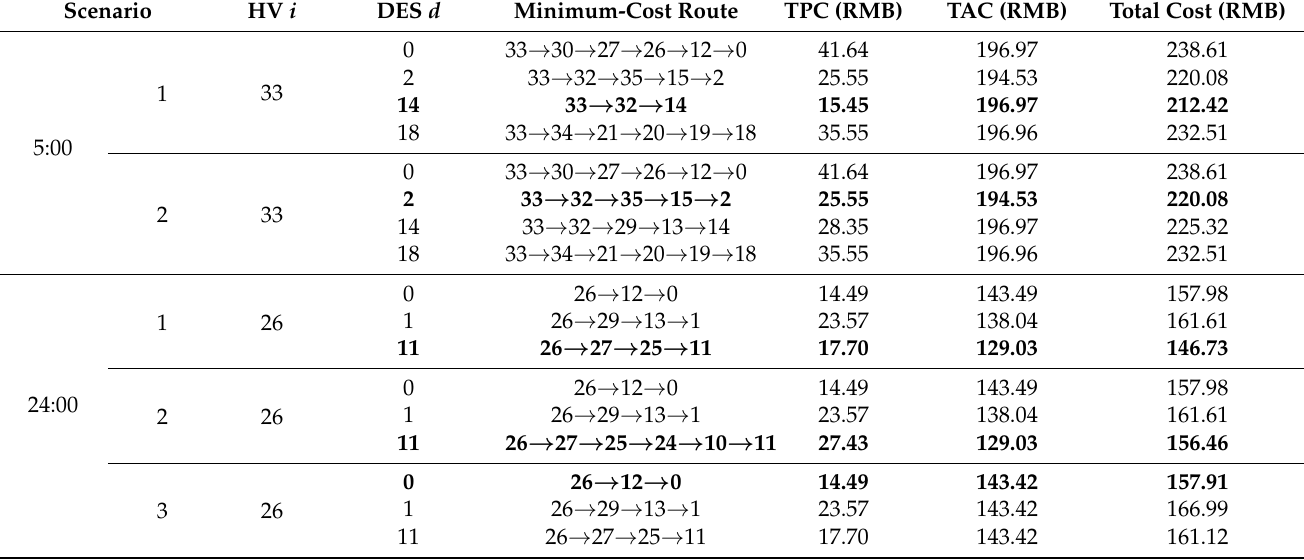
Table 7. Optimal results of HV routing